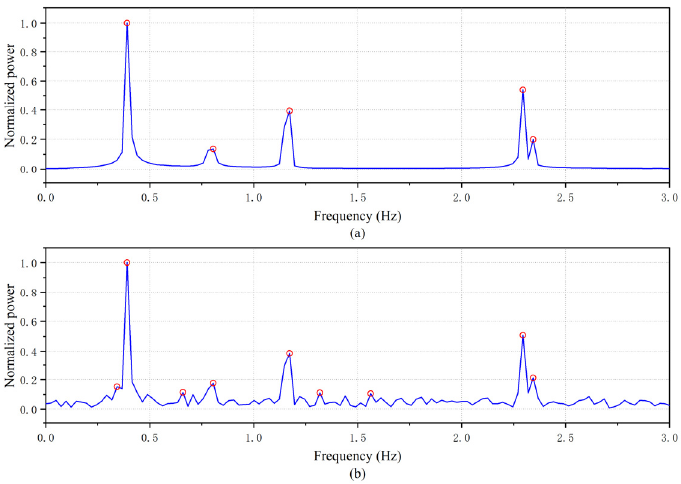
Figure 8. The amplitude–frequency characteristics using FFT. The red circles indicate estimated frequencies. ( a ) The results at SNR=30; ( b ) The results at SNR=10.